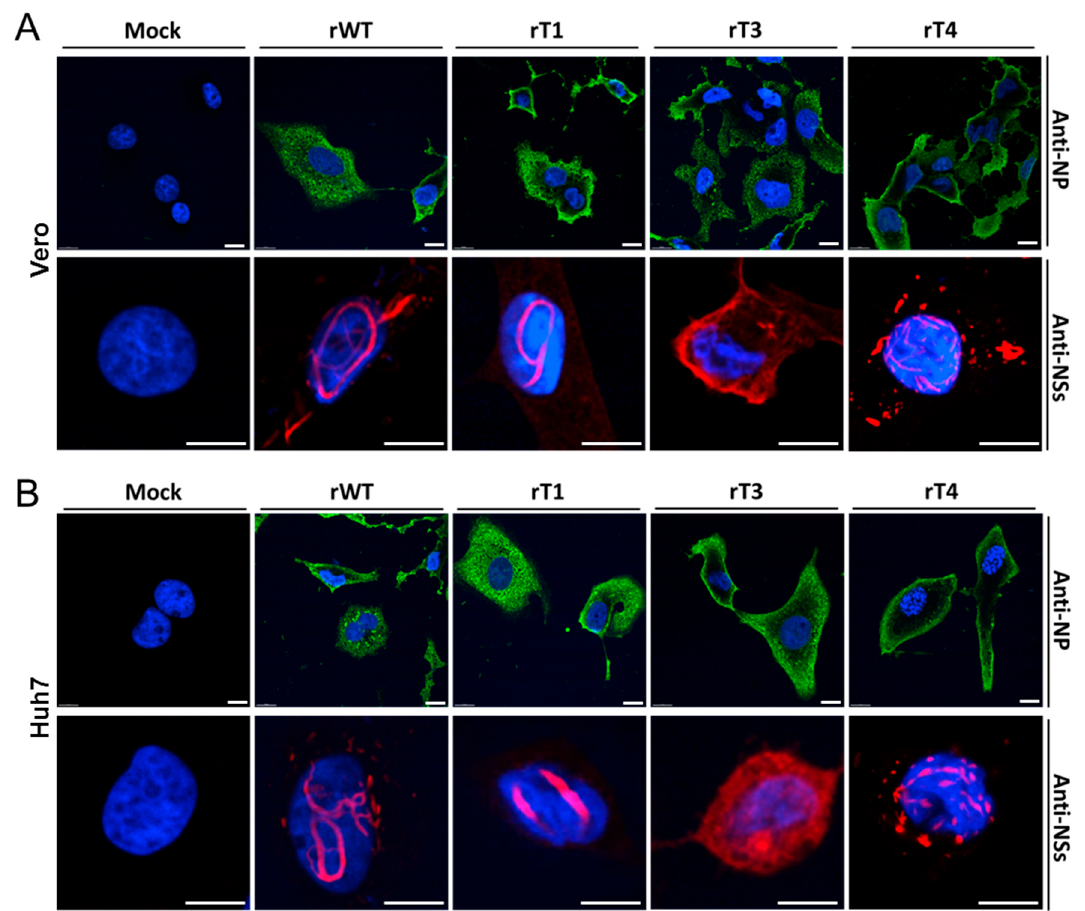
Figure 4. Analysis of NSs filament formation in infected cells. Vero ( A ) and Huh7 ( B ) cells were infected with indicated viruses (MOI = 5) and fixed at 24 h p.i. The infection and filament formation were analyzed by immunofluorescence microscopy using anti-N (green) or anti-NSs antibodies (red) as indicated. Nuclei were stained with DAPI. Bars, 10 μ m.